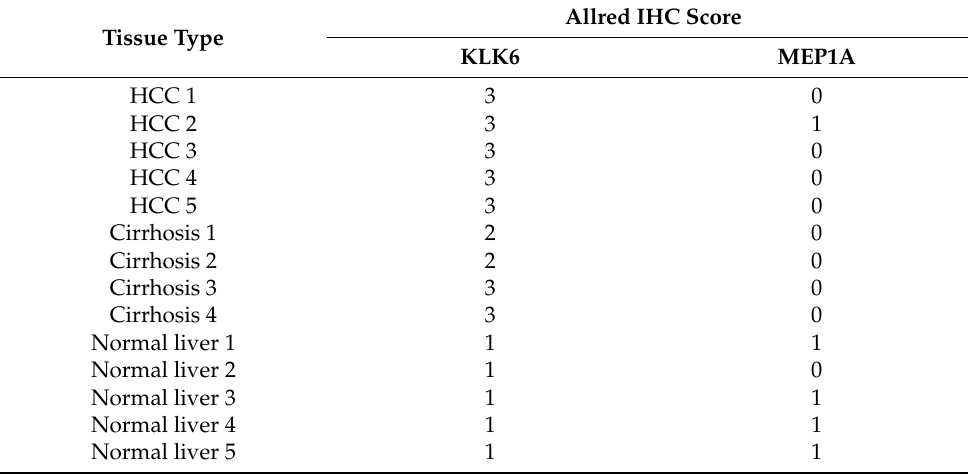
Table 5. Allred Scoring for all retrieved tissue specimens in the study. Tissue